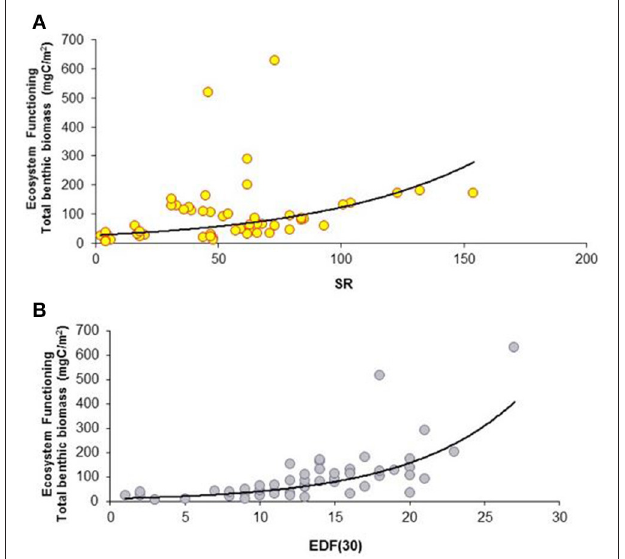
FIGURE 2 | Large spatial-scale relationships between macrofaunal biodiversity and ecosystem functioning and efficiency. (A) Relationship between species richness (SR) and ecosystem functioning expressed as total benthic biomass (mgC/m 2 ). The equation of the fitting line is y = e ∧ ( − 1.08 + 0.13x) ( N = 64; R 2 = 0.98; P < 0.001). (B) Relationship